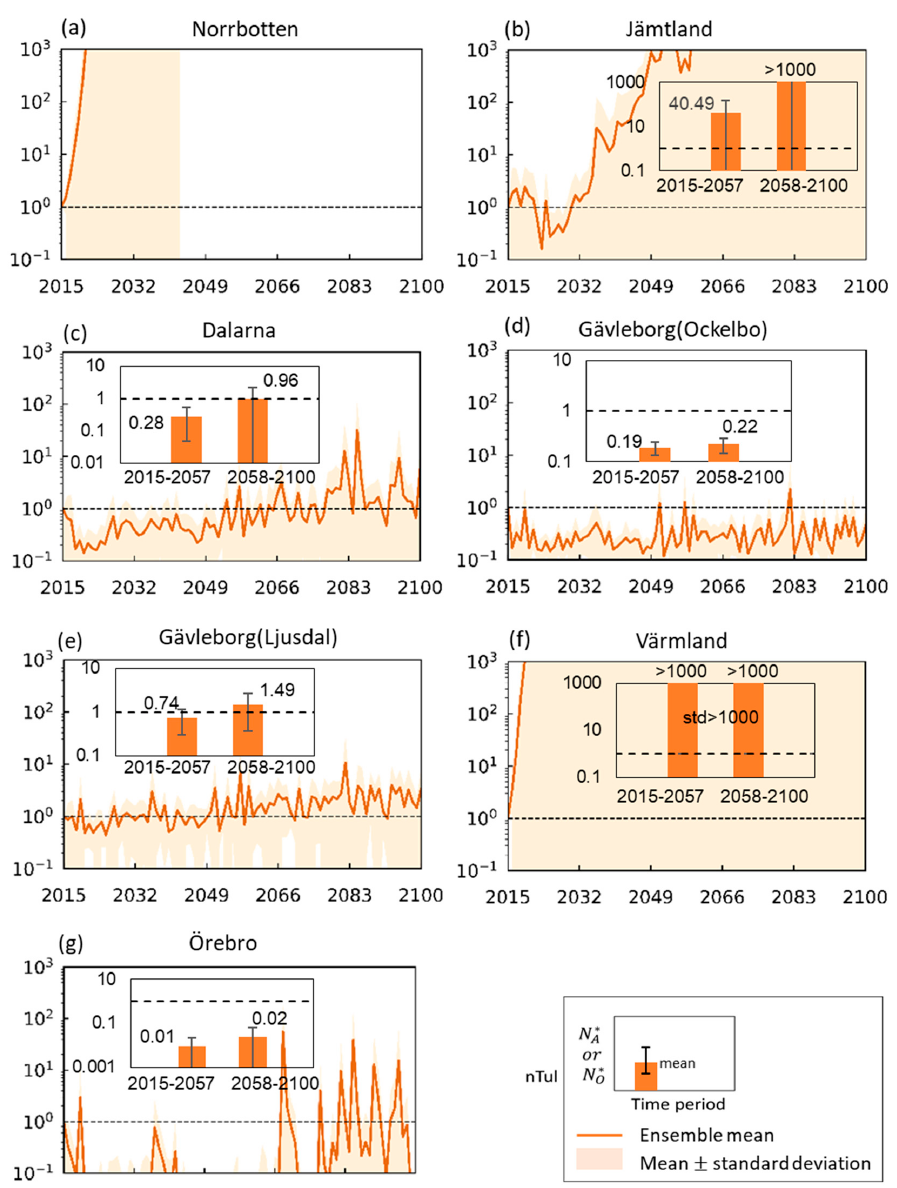
Figure 5. Normalized projected ensemble mean number of annual tularemia cases (nTul) for 2015–2100, and (inserts) associated normalized endemic levels ( N (cid:2885)∗ or N (cid:2899)∗ ) for the periods 2015–2057 and 2058–2100. Results are shown for the Swedish counties Norbotten ( a ), Jämtland ( b ), Dalarna ( c ), Gävleborg (two sites) (( d ) and ( e )), Värmland ( f ), and Örebro ( g ) under CMIP6 climate scenario SSP2-4.5. The shaded areas (main figures) and error bars (inserts) show ± 1 inter-model standard deviation around the model ensemble mean.